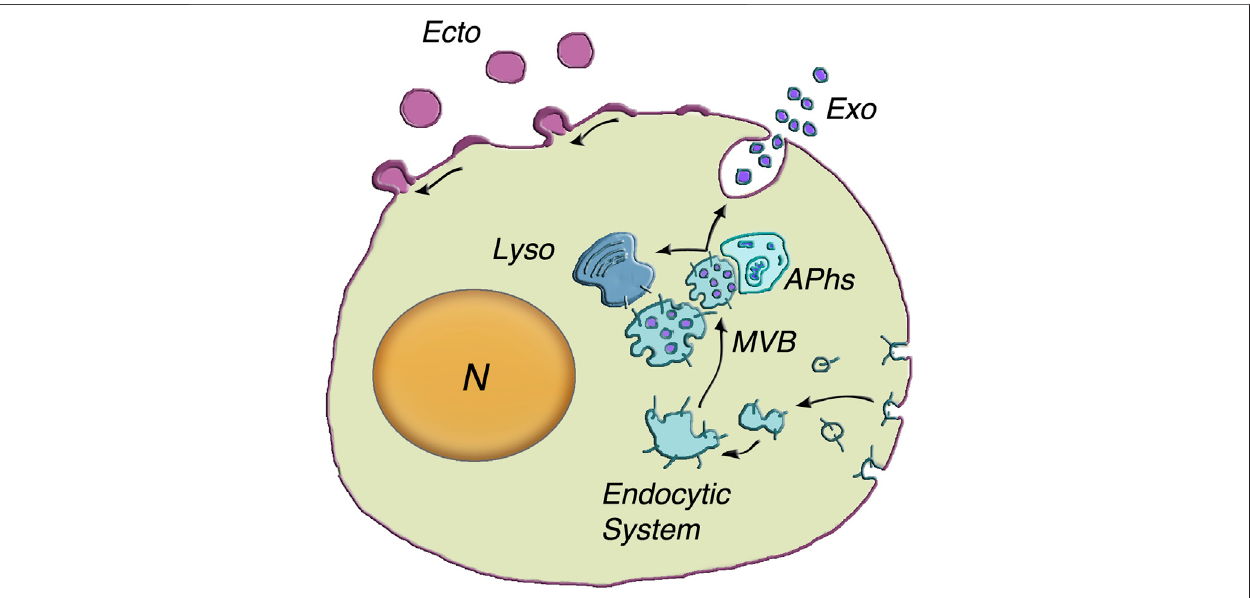
FIGURE1| Generationandreleaseofbothexosomesandectosomes.ThedependenceofexosomegenerationontheEndocyticSystemisillustratedatthecenter of the fi gure. The multivesicular body (MVB) is an endocytic vacuole occupied by vesicles corresponding to distinct intraluminal vesicles (ILVs) fi lled by speci fi c cargo accumulated from the cytosol. The inward budding of the vesicles is followed by their fi ssion and the release of ILVs into the MVB lumen (50 – 150 nm diameter). Upon their generation, the MVBs can proceed in two alternative directions (arrows): towards lysosomes (Lyso) or towards the plasma membrane. Their close interaction with autophagosomes) can induce reciprocal exchange of cargo components and ensuing increased fusion in response to stimulation. MVB exocytosis is followed by prompt extracellular release of vesicles, now named exosomes (Exo). The assembly and release of ectosomes, on top left of the cell surface, take place at the plasma membrane. The initial stepis theassembly ofmembranelarger microdomains(100 – 400 nm inectosomediameter). Their compositionisdistinctfrom that ofthe plasma membrane of origin and partially similar to that of ILV membranes. Concomitantly speci fi c cargos, composed of proteins, lipids and nucleic acids, accumulate in the vesiclelumen.Upontheirrapidoutwardcurvatureandbudding,theectosomevesicles(Ecto)undergopinchingoffandsheddingtotheextracellularspace.N=nucleus. Modi fi cation of the image reproduced with permission from Meldolesi (2018).